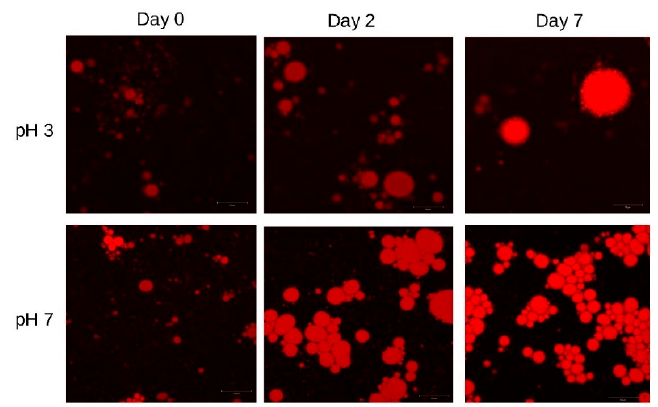
Figure 4. Confocal micrographs of miglyol-in-water emulsions prepared using the extract obtained from partially composted olive waste + leaf mixtures at extraction pH 5 (OC5). The pH values of the emulsions are 3 (top) and 7 (bottom); migrographs are taken (from left to right) upon preparation; after two days of storage; and after seven days of storage.